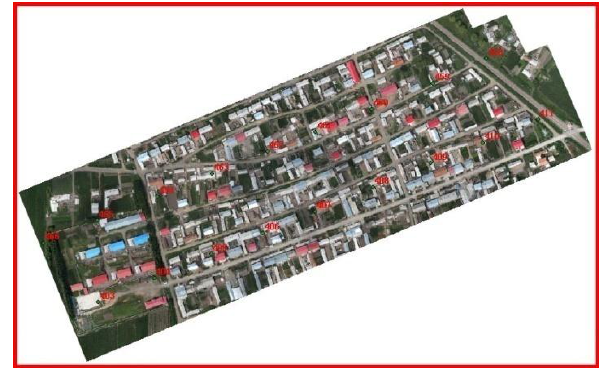
Figure 1. Flight rout graph of area